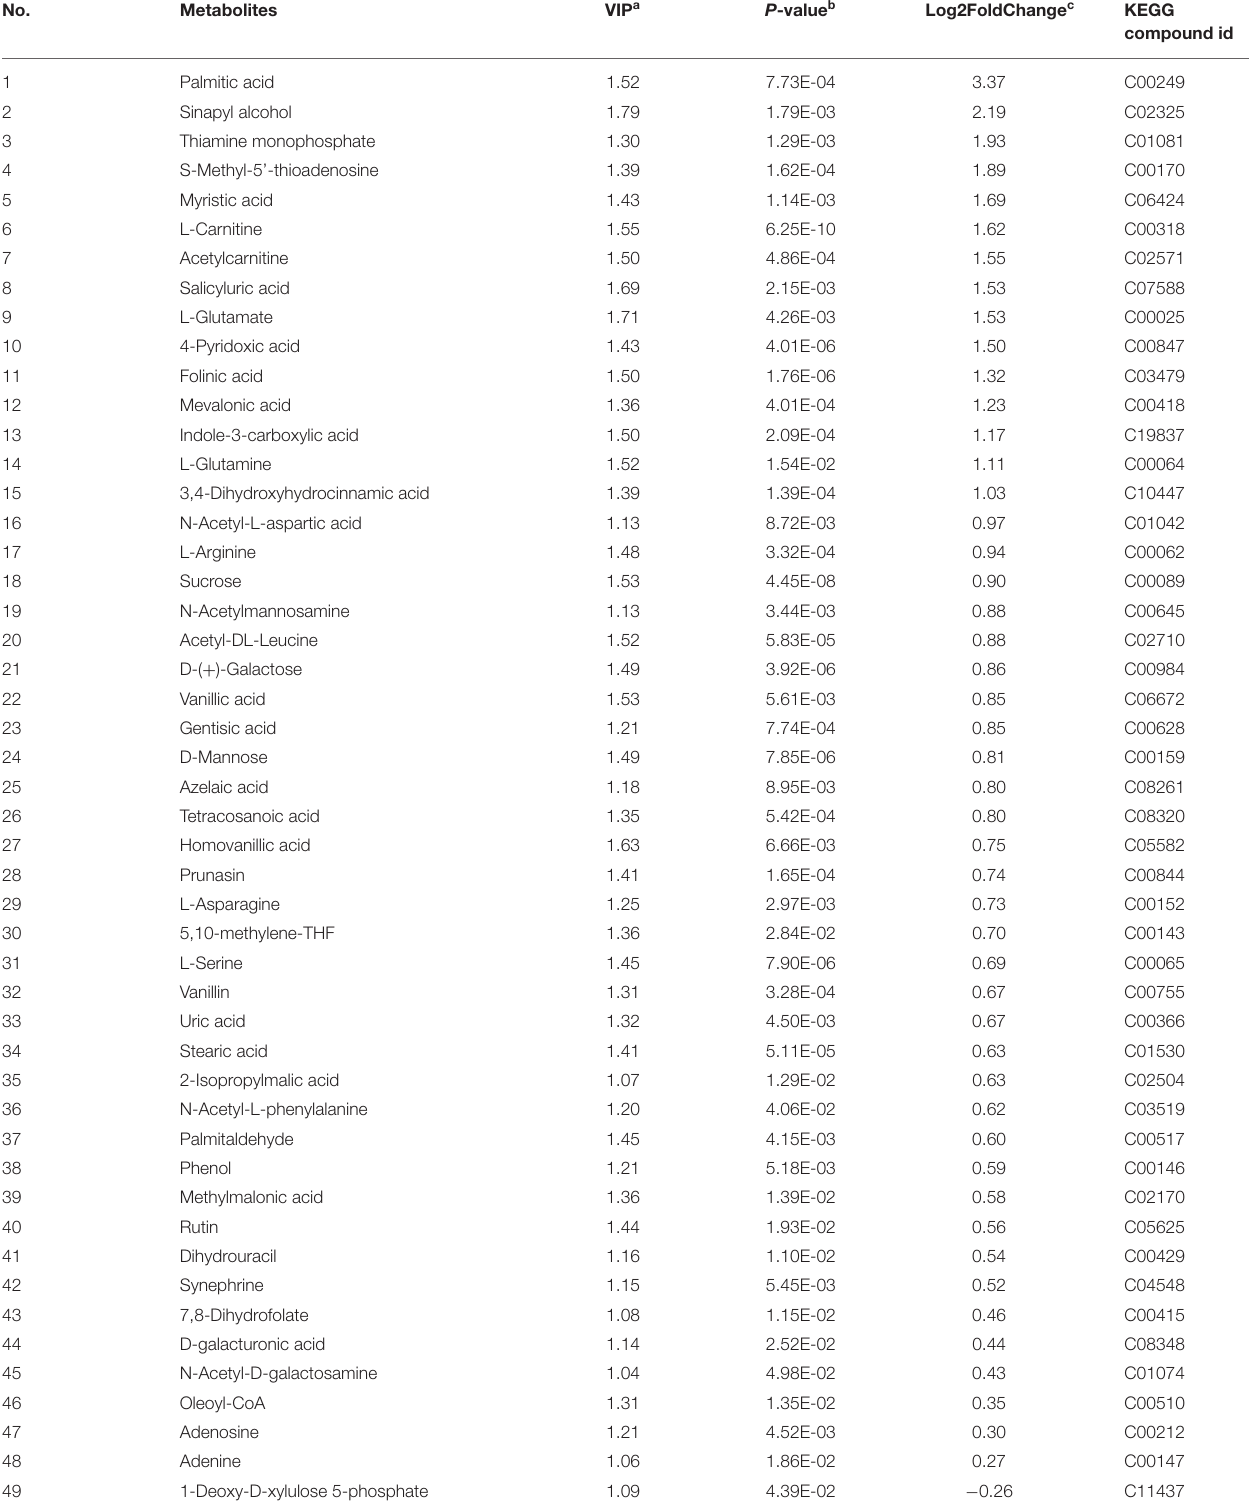
TABLE 1 | Differentially accumulated metabolites (DAMs) between C. L. asiaticus ( C Las)-infected and healthy